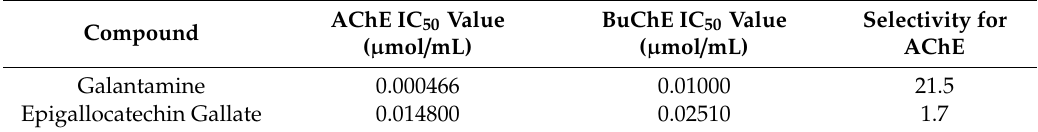
Table 12. IC 50 comparison for AChE and BuChE.